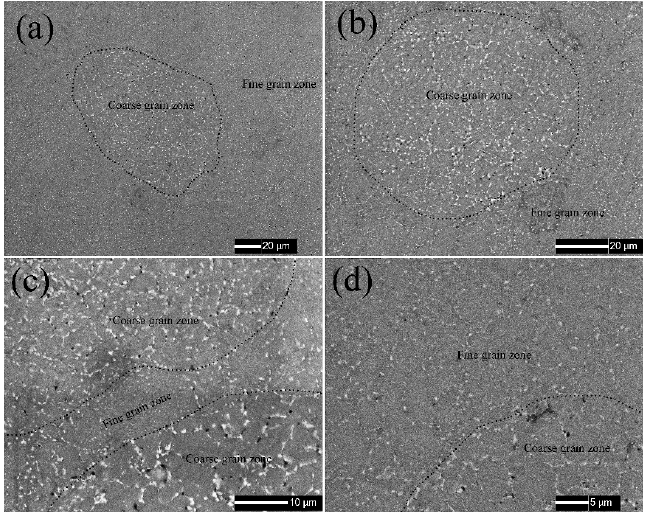
Figure 3. Typical SEM images of sintered 7075 alloys, ( a,b ) AL4, ( c ) AL3, and ( d ) AL5.